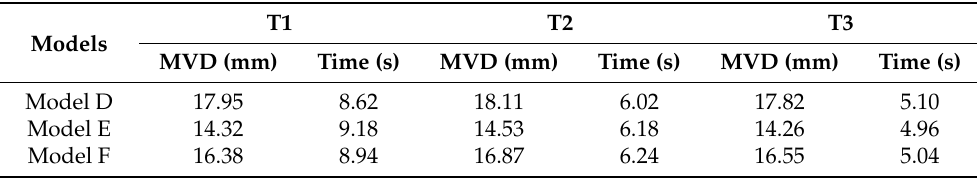
Table 10. The maximum vertex displacement in the X-direction.